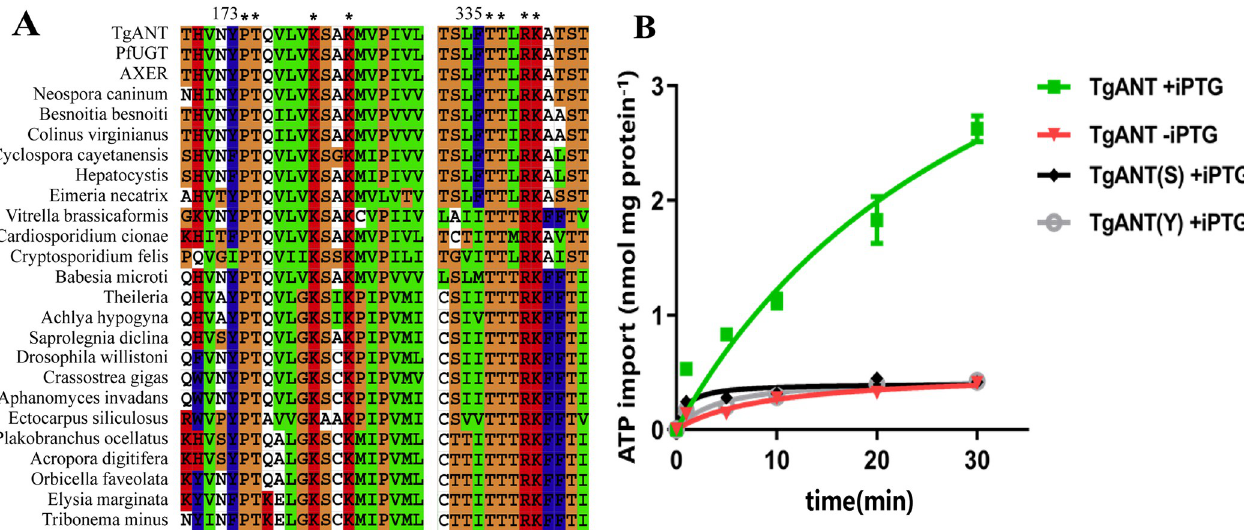
Fig 6. Conserved protein domain prediction and the absorb experiment of E . coli cells harboring mutant plasmid. (A) Conserved protein domain of TgANT were searched in NCBI. These two conserved domains are conserved in many species, such as mollusks, fungal, drosophila willistoni. (B) IPTG- induced E . coli cells harboring the plasmid encoding mutant cDNA of TgANT (pet16b-TgANT- 173 YSxxxxQxxQ, Gray hollow dots, and pet16b- TgANT- 335 SSxQQ, Black dot) were incubated with 25 nM [ α - 32 P] ATP for the indicated time intervals. IPTG-induced or Noninduced E . coli cells harboring the plasmid encoding wild-type TgANT were used as control. Means ± s.e.m., data of three independent